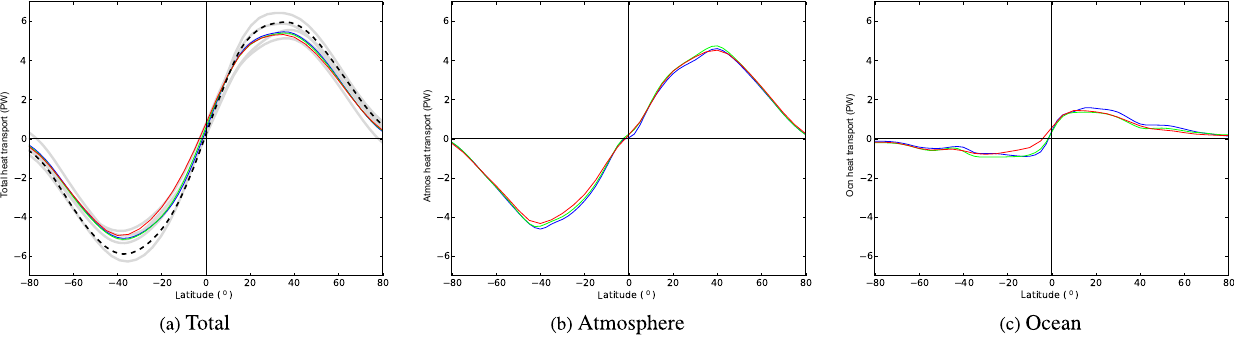
Figure 5. The annual mean northward heat transport in total, the atmosphere, and the ocean. The black line shows the observational estimate, blue HadCM3B-M2.1a, green HadCM3BL-M2.1a, and red FAMOUS-M2.2; grey lines show transports for a selection of CMIP5 models. These transports are calculated as the implied heat transports from the TOA and surface energy fluxes (see Trenberth and Fasullo, 2013, for details). Observational estimates for the total transport are derived from the CERES